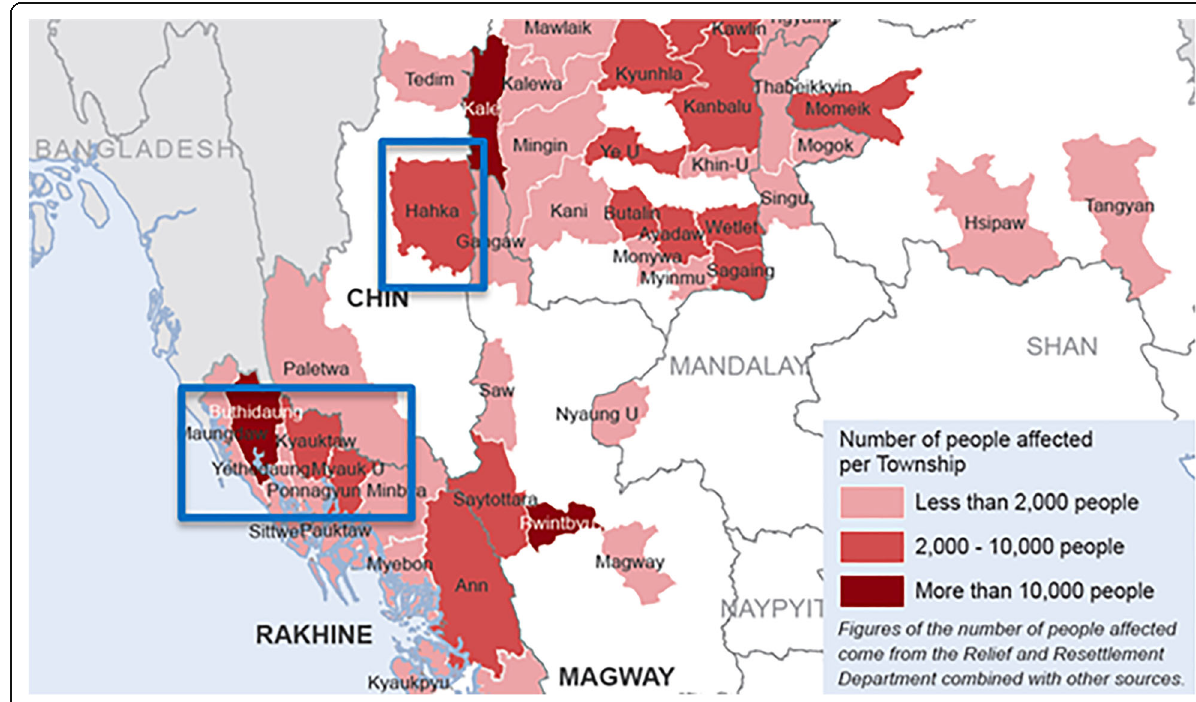
Fig. 1 Case study areas and 2015 flood-affected townships. Case study areas (framed in blue) and flood-affected areas compiled based on government and humanitarian sources on 3 August 2015 (in red). Source: modified based on UN Office for the Coordination of Humanitarian Affairs